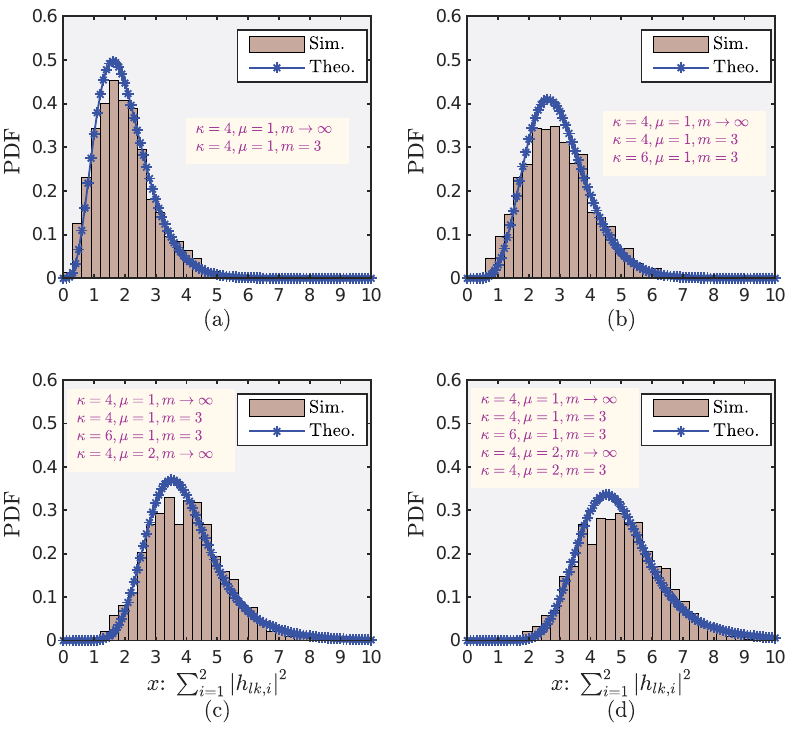
Figure 3. PDFs of the sum of i.n.i.d. κ – µ shadowed RVs .( a ) Case 1; ( b ) Case 2; ( c ) Case 3; ( d ) Case 4.